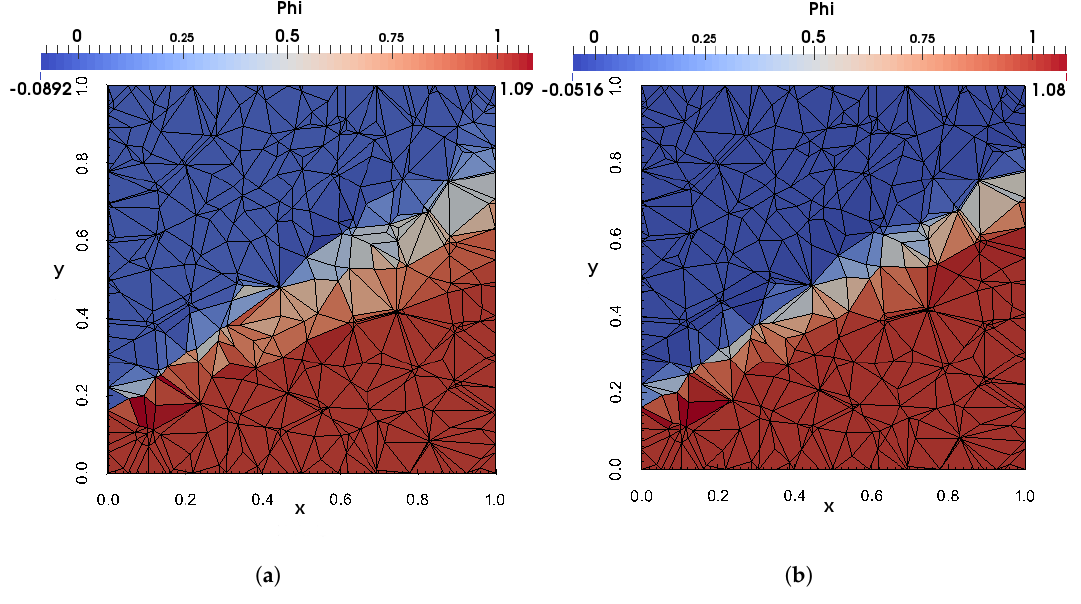
Figure 14. Slice of a three-dimensional step -profile at z = 0.5 m on a mesh with 7982 tetrahedra. ( a ) TVD-vanLeer; ( b ) limited WENOUpwindFit